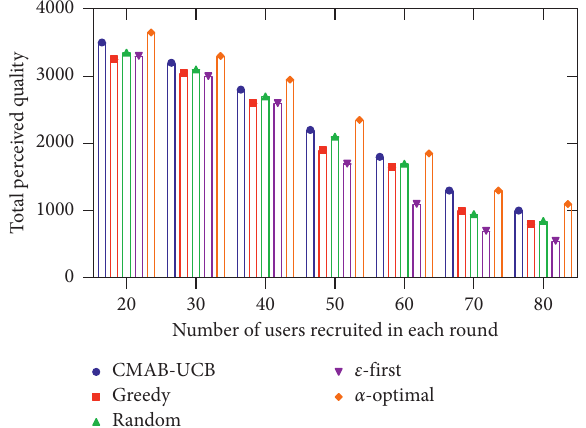
Figure 3: The relationship between perceived quality and user recruitment in each round ( b �